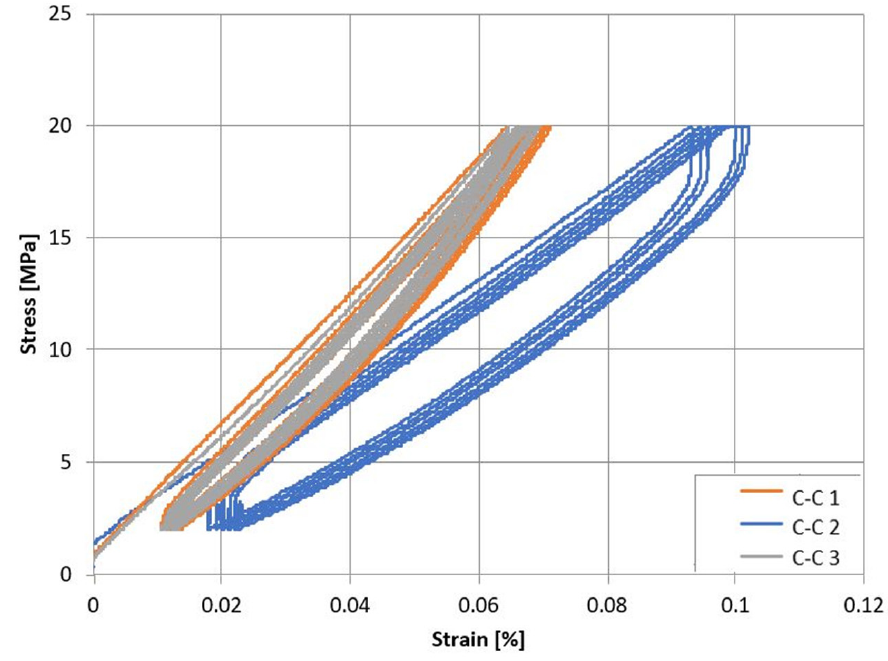
Figure 5. Stress–strain dependence for C-C series concrete.